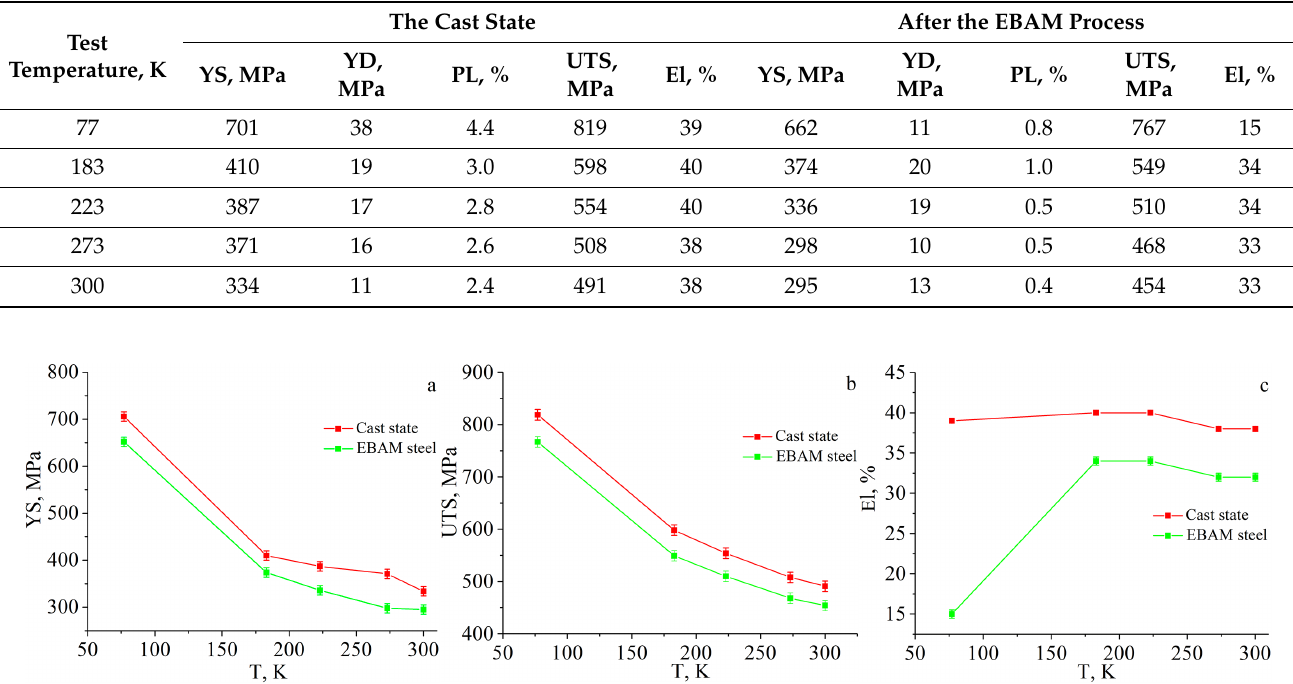
Figure 6. SEM images of the lateral surfaces of the low ‐ carbon steel: ( a ) cast and ( b ) EBAM. Speci ‐ mens were tensile tested to failure at 300 K. SEM images of the lateral surfaces of the low ‐ carbon steels subjected to tensile testing at 77 K are shown in Figure 7. Plastic deformation of cast specimens developed by multi ‐ ple shears (Figure 7a), slip, and twinning is the dominating deformation mechanisms at low temperatures [13]. Microcracks are clearly observed on the lateral surfaces of these specimens. They are not large and located near grain boundaries, macroshear bands, or